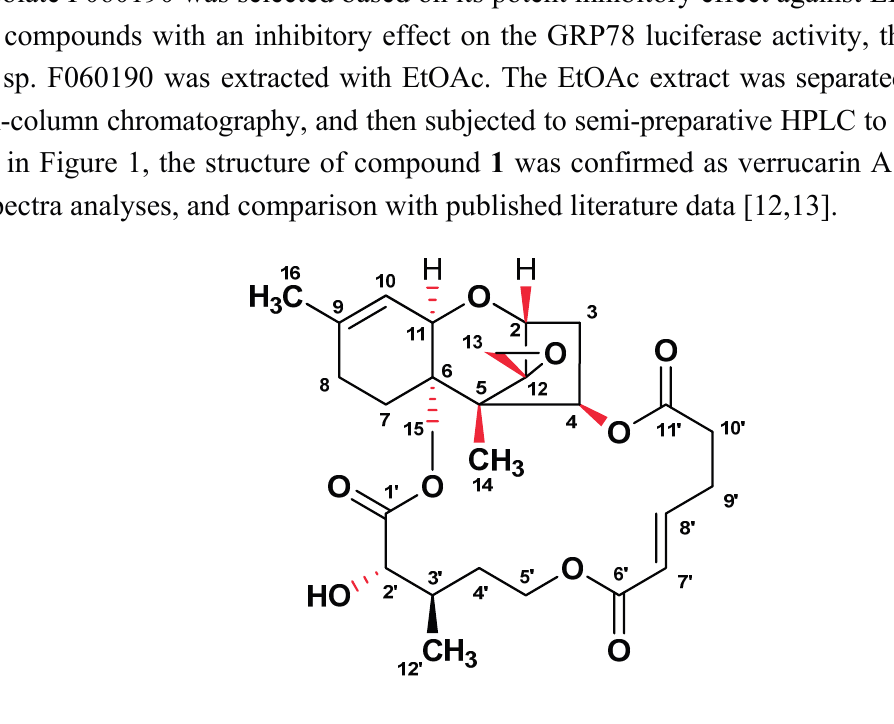
Figure 1. Chemical structure of verrucarin A isolated from the culture broth of Fusarium sp.